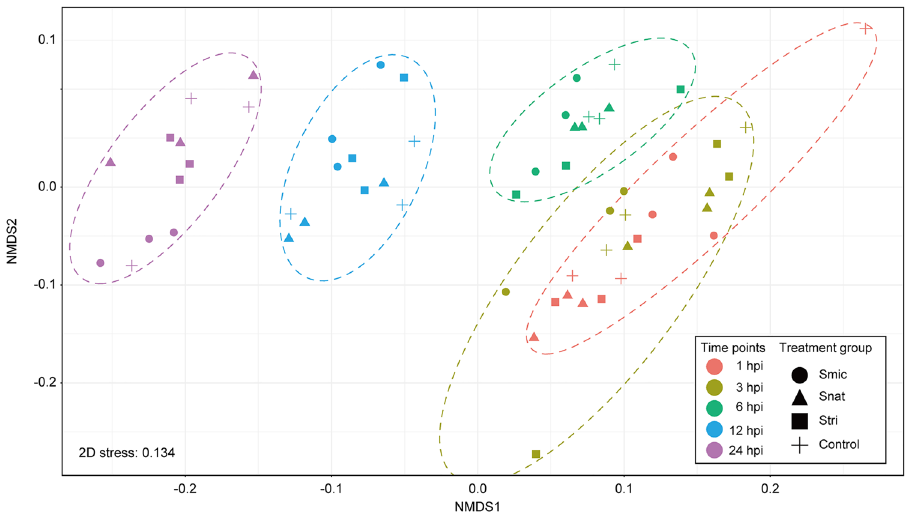
Figure 1. Non-metric multidimensional scaling (NMDS) of RNA-seq samples based on expression levels of Acropora tenuis genes. Gene expression levels among all samples were normalized using the trimmed mean of M values method, and then converted to CPM. A total of 5340 genes for which expression levels (TMM- normalized CPM) were larger than 10 in all samples were used with the “metaMDS” of the vegan package 73 . 2D stress was 0.134. Ellipses (dotted line) are drawn around each time point using “geom_mark_ellipse” of the ggplot package 74 . Hpi indicates hours